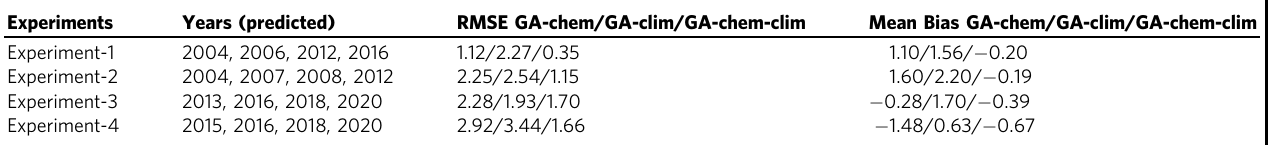
Table 3 Root mean squared error (RMSE) and mean bias between observations and HABs severity index for GA-chem and GA-chem-clim models for experiments 1 to